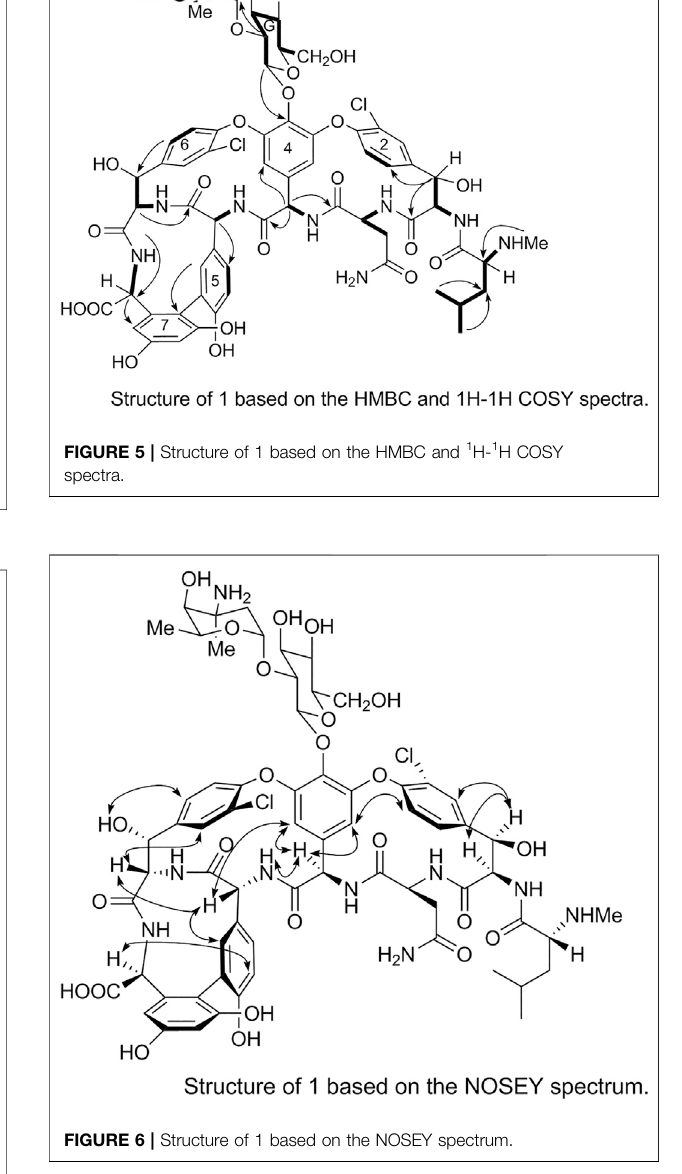
FIGURE 4 | Amino acid fragment 2.